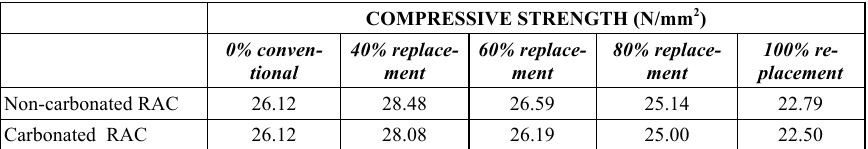
Table 4. Compressive strength of non-carbonated and carbonated RAC